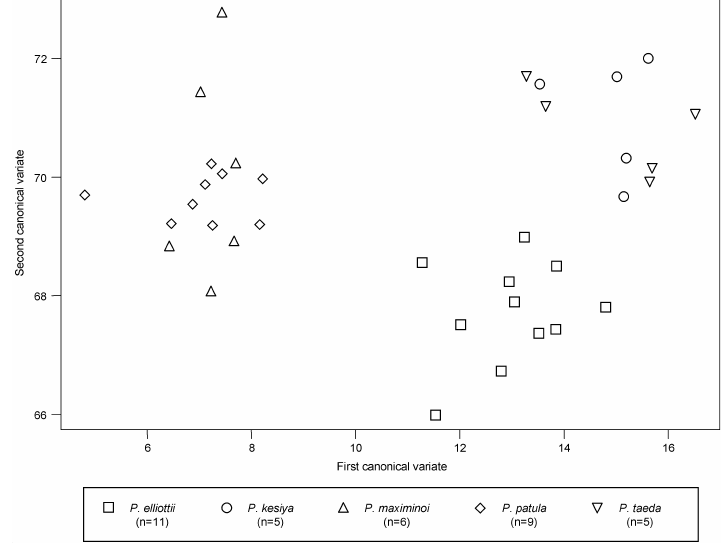
Figure 1: Scatterplot of the first and second canonical variate scores of five pine